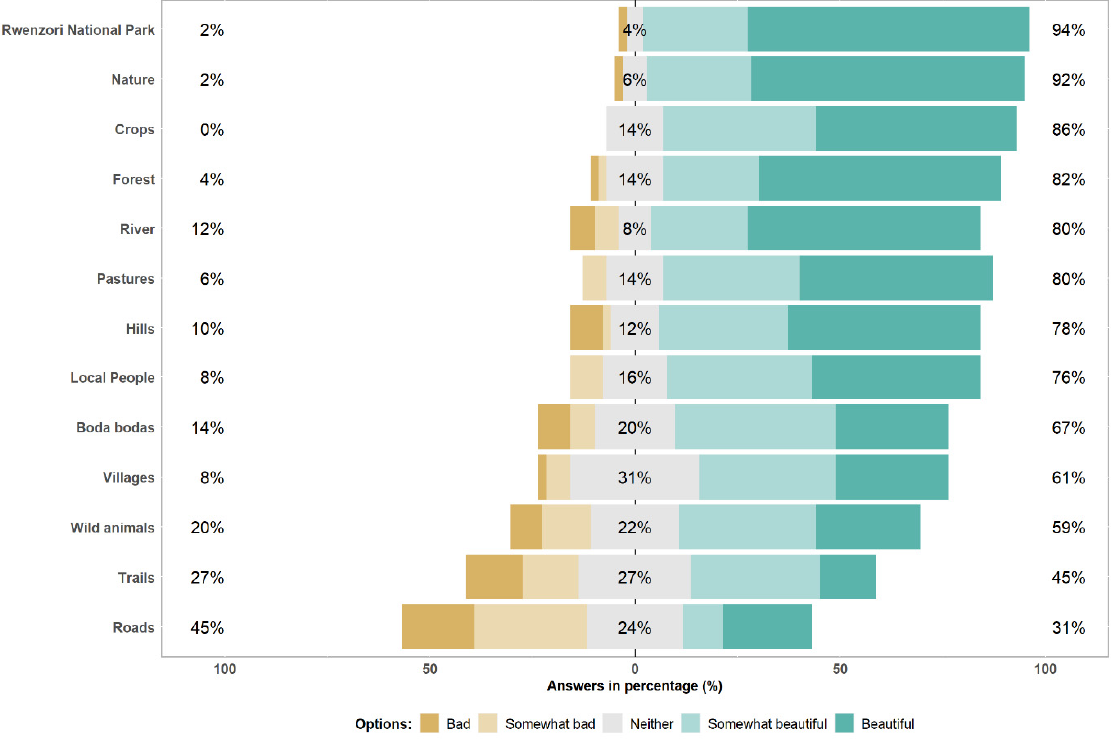
Figure 3. Scenic beauty of biological, physical and human engineered facilities and devices of the Mubuku valley and Rwenzori Park, as assessed by Ruboni